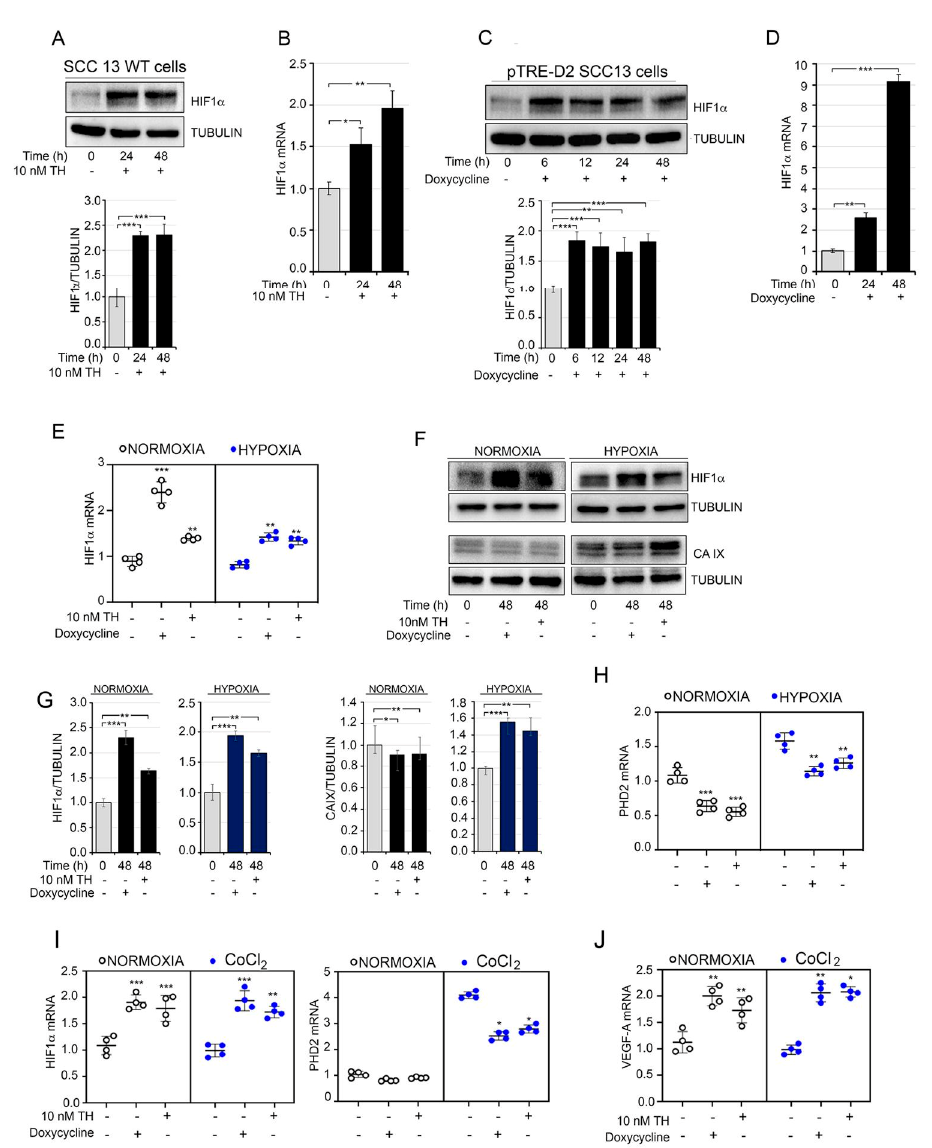
Figure 4. TH regulates the cellular response to hypoxia. ( A ) SCC13 cells were treated with 10 nM TH for 24 and 48 h. Total protein lysates were used for Western blot analysis of HIF1 α . Tubulin expression was measured as the loading control (top). Quantification of the HIF1 α protein versus tubulin levels is represented by a diagram (bottom). ( B ) mRNA levels of HIF1 α in SCC cells treated as indicated in A . ( C ) Western blot analysis of HIF1 α was performed in pTRE-D2 SCC13 cells after D2 induction for 6–12–24–48 h. Quantification of the HIF1 α protein versus tubulin levels is represented by a diagram (bottom). ( D ) mRNA levels of HIF1 α in pTRE-D2 SCC13 cells ±2 μ g/mL doxycycline for 24–48 h. * p < 0.05, ** p < 0.01, *** p < 0.001. ( E ) mRNA expression levels of HIF1 α under normoxic and hypoxic conditions in pTRE-D2 SCC13 cells after D2 induction or TH treatment for 48 h. ( F ) Western blot analysis of HIF1 α and CA IX in pTRE-D2 SCC13 under normoxic and hypoxic conditions after D2 induction or TH treatment for 48 h. ( G ) Quantification of HIF1 α and CA IX expression levels are represented by diagrams. ( H ) mRNA levels of PHD2 in pTRE-D2 SCC13 cells under normoxic and hypoxic conditions after D2 induction or TH treatment for 48 h. ( I , J ) mRNA levels of HIF1 α PHD2 and VEGF-A were measured by real-time PCR analysis in pTRE-D2 SCC13 cells under normoxic and chemical hypoxic conditions (CoCl 2 ) after D2 induction or TH treatment for 48 h. One representative experiment of 3 replicates is shown. * p < 0.05, ** p < 0.01, *** p < 0.001.